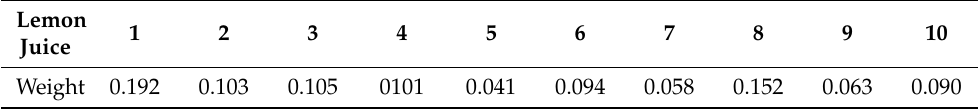
Table A28. Weight of each criterion for lemon